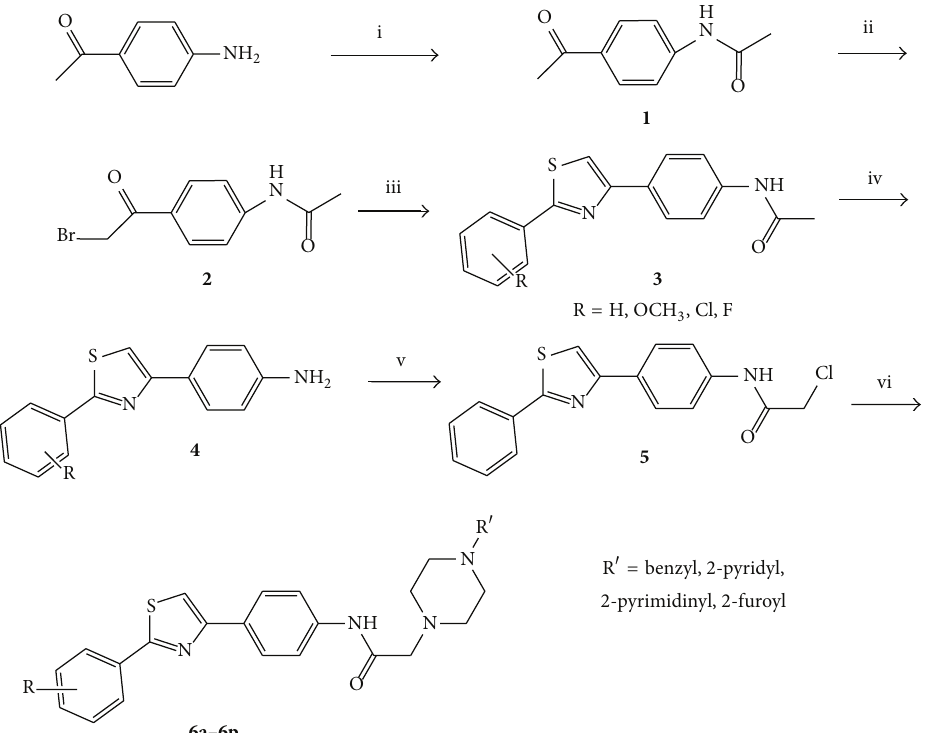
Figure 1: Synthesis of the compounds( 6a – 6p ). Reagents are (i) acetyl chloride, TEA, THF, 0–5 ∘ C; (ii) Br 2 , AcOH; (iii) thiobenzamide derivatives, EtOH, r.t.; (iv) 10 % HCl, EtOH, reflux; (v) chloroacetyl chloride, TEA, THF, r.t.; and (vi) appropriate 4-substituted piperazine derivatives, K 2 CO 3 , acetone,